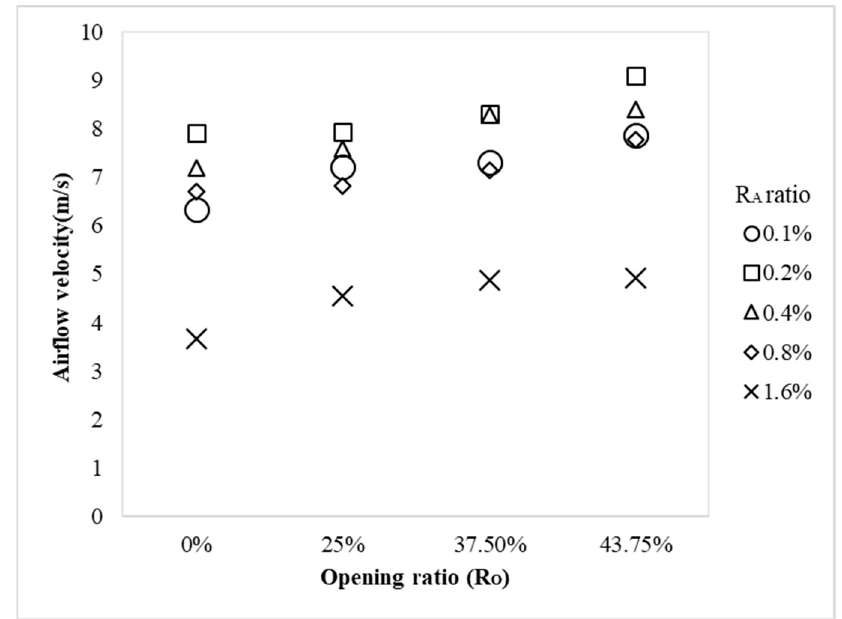
Figure 13. Average air flow velocity corresponding to opening ratio of OWC gate.